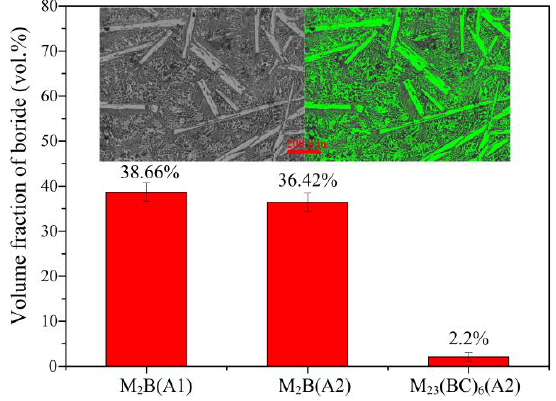
Figure 3. The volume fraction of borides.